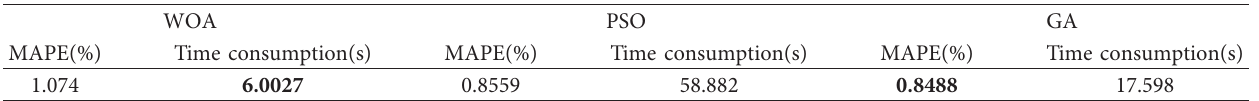
Table 7: The minimum MAPE and time consumption of WOA, PSO, and GA in Case 2.